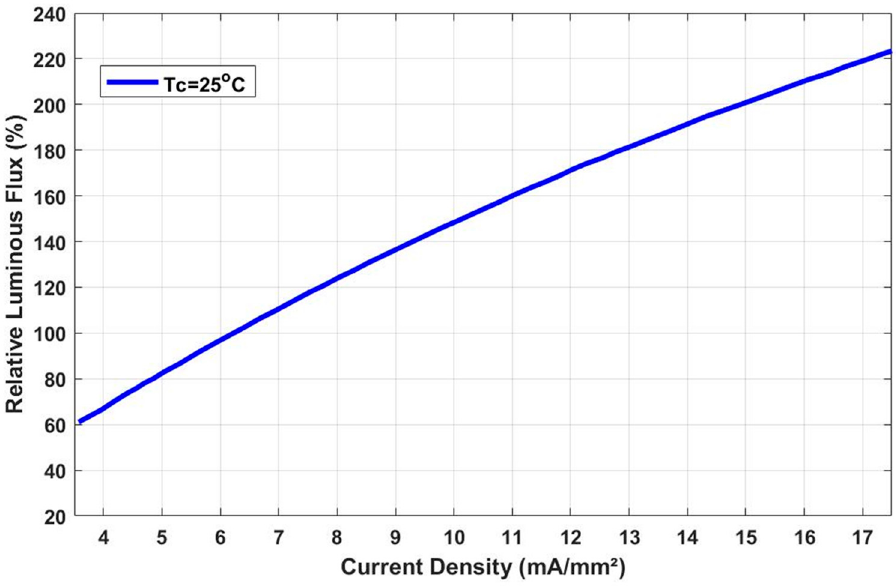
Figure 1. Curve of current density vs. RLFR for CXB1304 LED array under 25 °C.